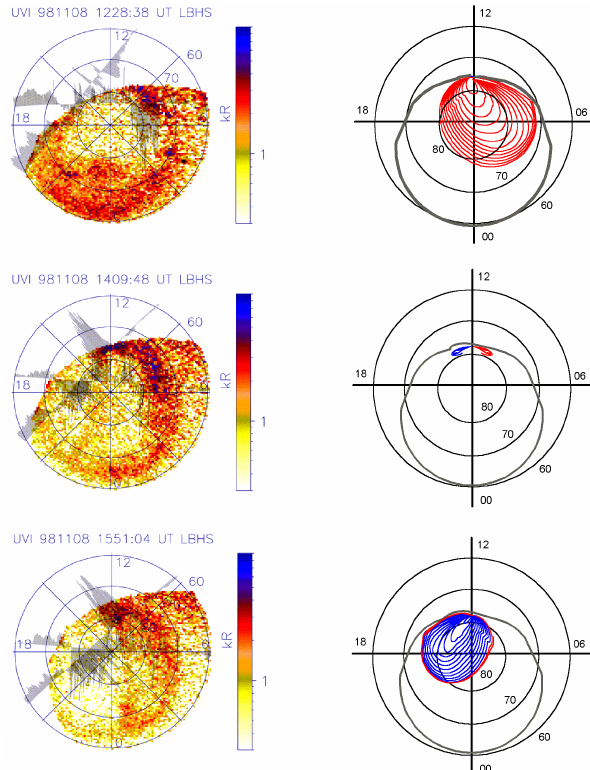
Fig. 9. Left: Data shown from three DMSP passes on 8 November 1998 (12:17–12:41, 13:59–14:19, and 15:41–16:01 UT) that occur during the Polar UVI data period. DMSP F13 and F14 horizontal plasma flows, perpendicular to the satellite track, are plotted over a UV image taken at the time when F13 is at highest magnetic lati- tudes. Right: For the same 3 times are shown the modelled polar cap boundary, auroral oval, and polar cap convection generated by the solar wind electric field, as predicted by the Paraboloid Model. The model parameters for each case were calculated from solar wind data and geomagnetic indices. For UT=14:09:48 the TPA observed in the dusk sector may be explained by the time delay ( ∼ 20min) between the IMF turning and the ionospheric convection response (Clauer et al., 2001). At 13:49:48 UT IMF B y was slightly positive, which corresponds to the observed TPA location. Red curves show the electrostatic potential patterns (10kV contour separation). See text for